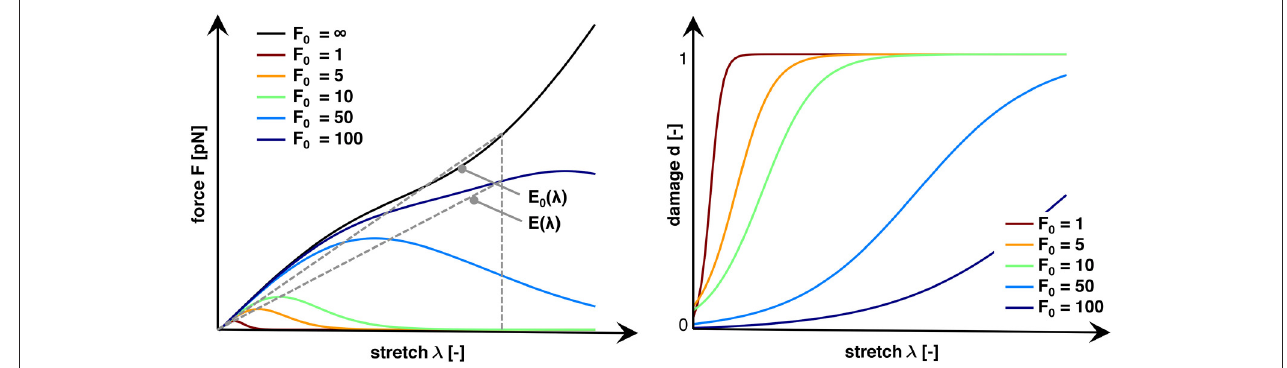
FIGURE 4 | Characteristic force vs. stretch and damage vs. stretch curves for varying characteristic bond strengths, F 0 . An infinite bond strength F 0 → ∞ defines the baseline, undamaged stiffness E 0 ( λ ). Finite bond strengths F 0 trigger a net increase in crosslink detachment resulting in an increase in damage d and a reduced axonal stiffness E ( λ ). Increasing the bond strength F 0 decreases the not crosslink detachment, which increases the stretch λ and force F required to trigger axonal damage. We define axonal damage, d ( λ ) = 1 − E ( λ ) / E 0 ( λ ), as the ratio of the reduced and undamaged secant stiffnesses E ( λ ) and E 0 ( λ